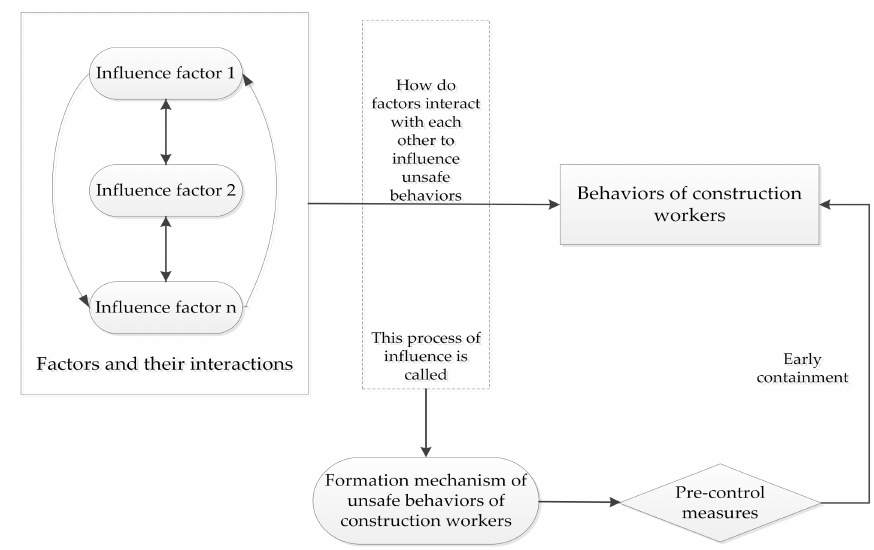
Figure 5. The research framework in the studied field.